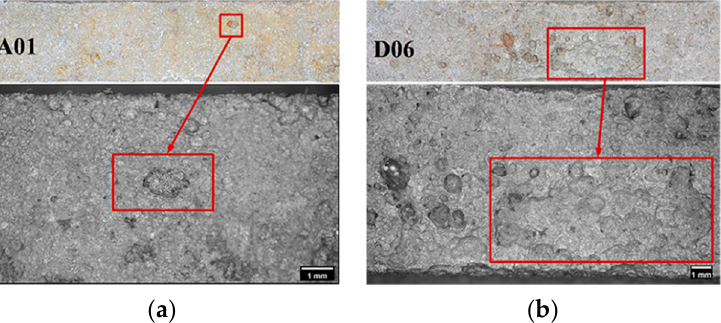
Figure 2. Surface morphology of corroded specimens: ( a ) Corrosion time: 60 days; ( b ) Corrosion time: 240 days [31].